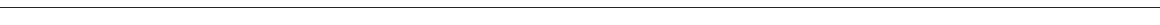
FIGURE4 staining for (B) GP IIb/IIIa and (C) TER-119 in plaques are shown. (D) The video intensity of MB R or MB C in mice was quantified. Quantitative analysis of the (E) GP IIb/IIIa coverage on the endothelium, (F) GP IIb/IIIa expression in plaques, and (G) the average number of red blood cells at 24h after treatment. (H) Bleeding times were assessed by surgical tail transection in the six treated mouse groups ( P > 0.05). (I) Platelets (black arrowheads) adhering to the site of atherosclerotic lesions were observed by scanning electron microscopy after the DUMB R treatment at an MI of 1.5 or 1.9 groups. Panel b and its magnified images in panel d show that the endothelium was incomplete (red arrowheads). (J) Average number of activated platelets was quantified. (K) Representative images of abdominal skin and mesentery stained with H & E. Red blood cells were observed in complete vessels (black arrowheads). n = 6 per group. * P < 0.05 vs. sham, # P < 0.05 vs. MI 0.9, & P < 0.05 vs. DU only, $ P < 0.05 vs. DUMB C , § P < 0.05 vs. MI 1.9 DUMB R ; DUMB R : diagnostic ultrasound combined with MB R . DUMB C , diagnostic ultrasound combined with MB C